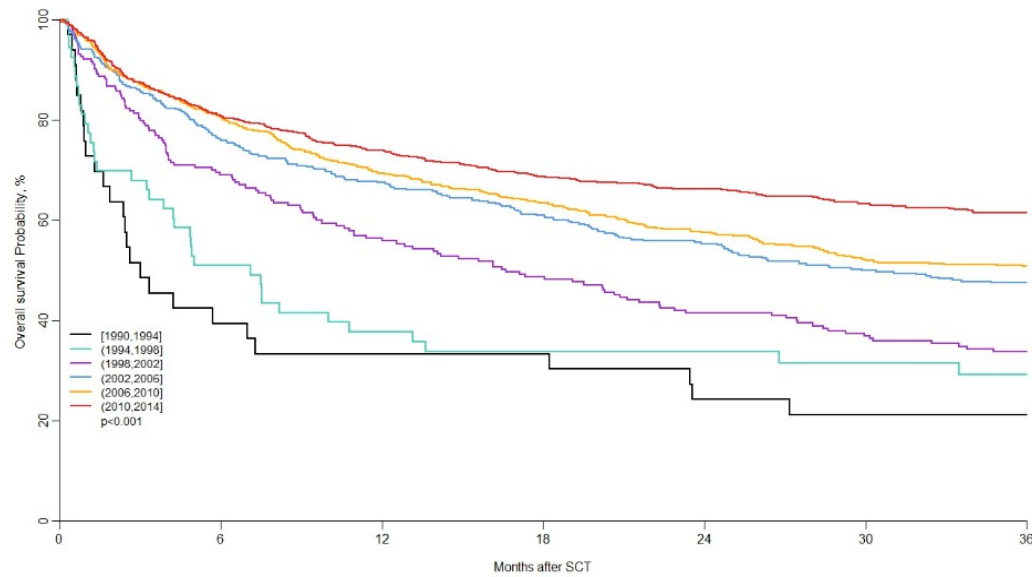
Figure 2. Long-term outcome (OS) of allo-SCT in patients with r/r cHL. Reproduced with permission [43],